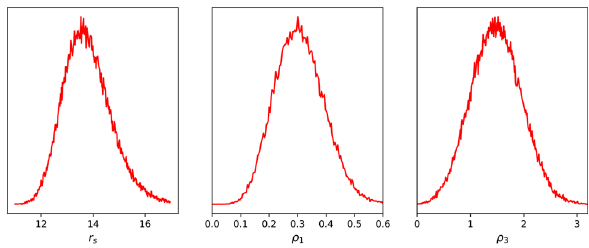
Fig. 3 Marginalized posterior distributions for the parameters char- acterizing the halo derived from the dipole of the neutral scalar field